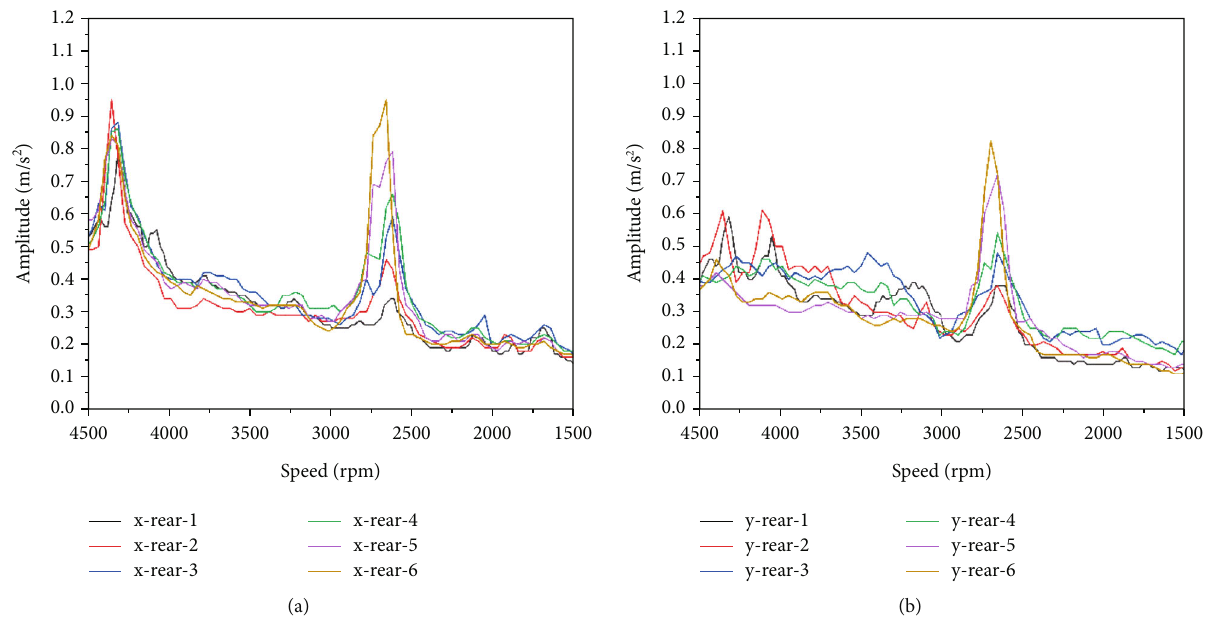
Figure 23: Acceleration response of the rear bearing during run-down process. (a) Response in the x -axis direction. (b) Response in the y -axis